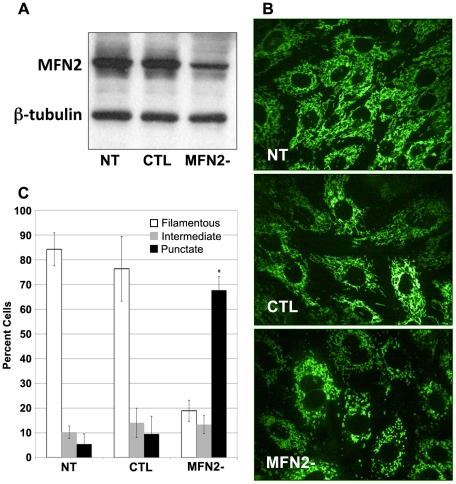
MFN2 deficiency causes fragmentation of mitochondria in vitro.(A) MFN2 content in MFN2f/f primary cell cultures treated with Cre adenovirus (MFN2-), empty adenovirus vector (CTL), or no virus (no treatment or “NT”). (B) Mitochondrial morphology in primary proximal tubule epithelial cell cultures treated as described in (A) above and then stained with MitoTracker Green FM before visualization with a confocal microscope. (C) Percentage of primary cells with filamentous, intermediate, or punctate mitochondria assessed by a blinded reviewer after transduction with adenovirus as described above; * P<0.05 vs. either NT or CTL; data represent the mean and SE of three separate experiments; P<0.05.